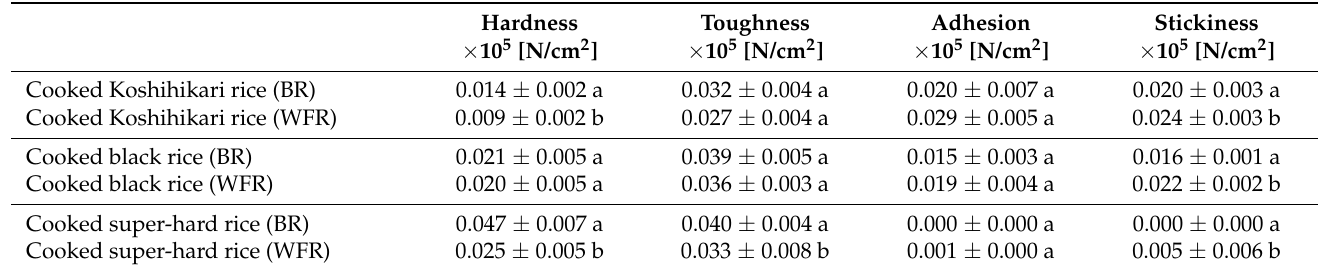
Table 1. Textural properties of various cooked brown rice and wax-free brown rice. Hardness